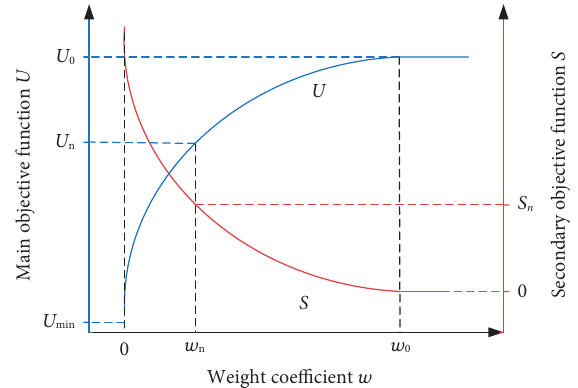
Figure 2: Objective function U/S and w